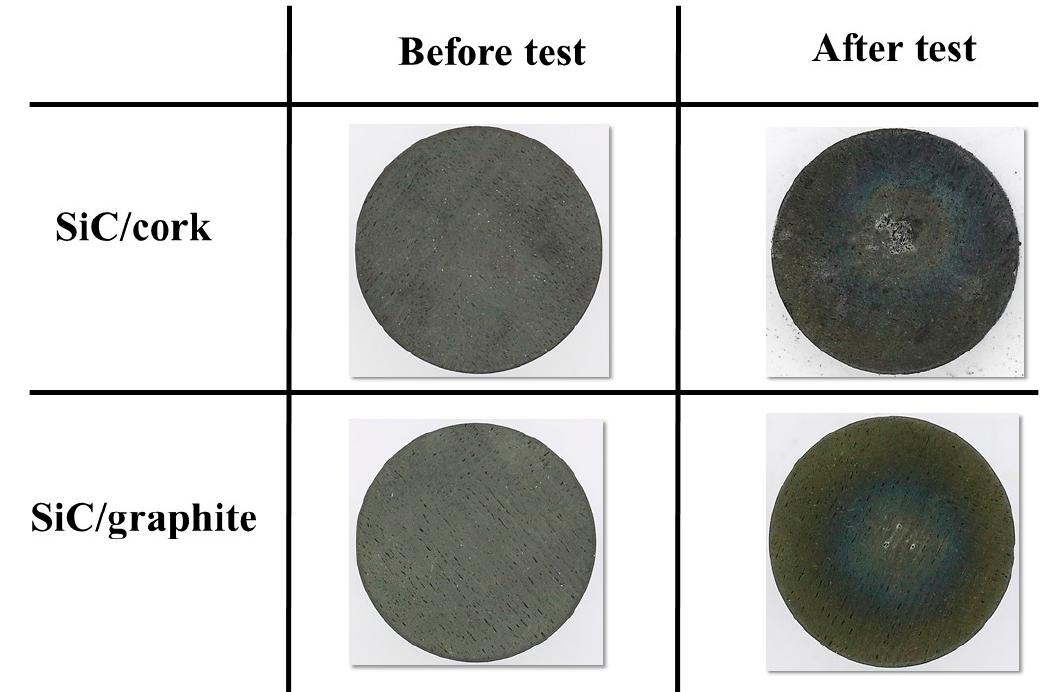
Figure 21. SiC-coated C–C specimens’ before and after test images (exposed surface).